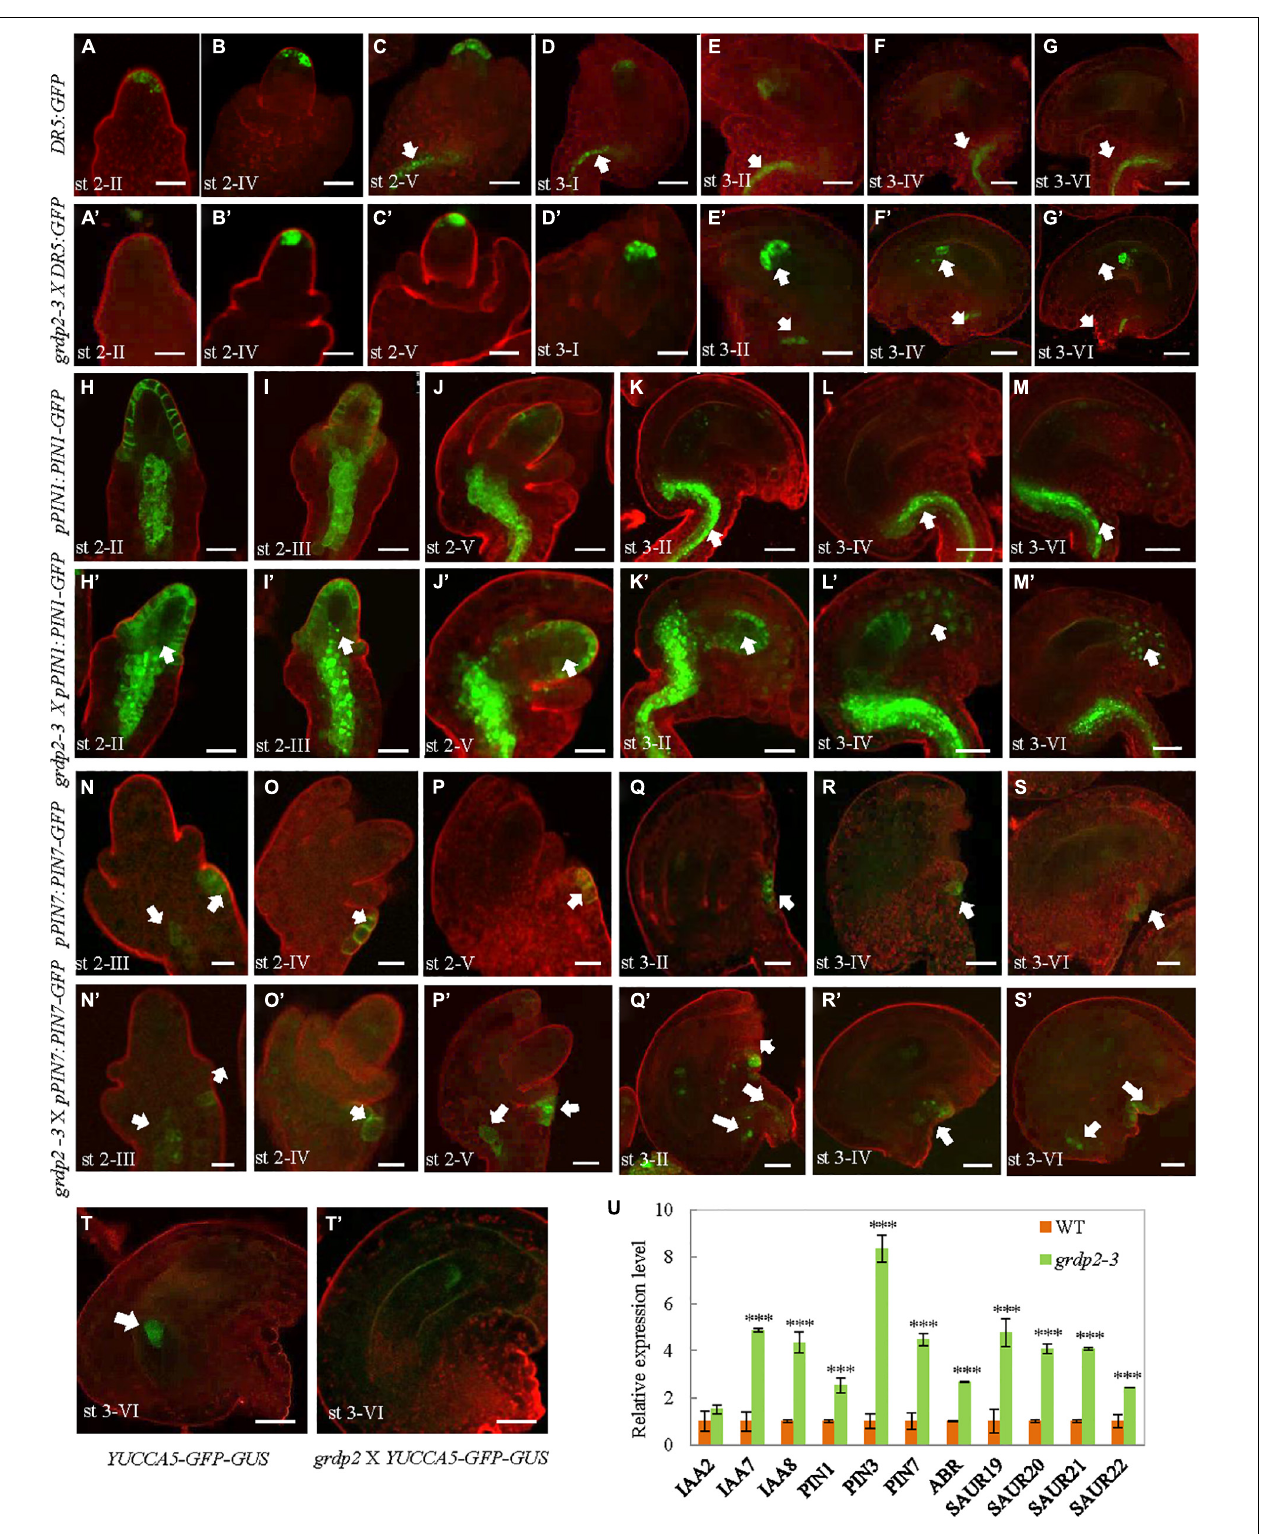
FIGURE 7 | Auxin distribution in developing ovules from WT and grdp2-3 siliques using DR5:GFP , pPIN1:PIN1-GFP , pPIN7:PIN7-GFP , and YUCCA5-GFP-GUS as an auxin reporter. (A–G) WT DR5:GFP ovules were analyzed at different developmental stages. (A) The cytoplasmatic GFP signal is first detected in the hypodermal